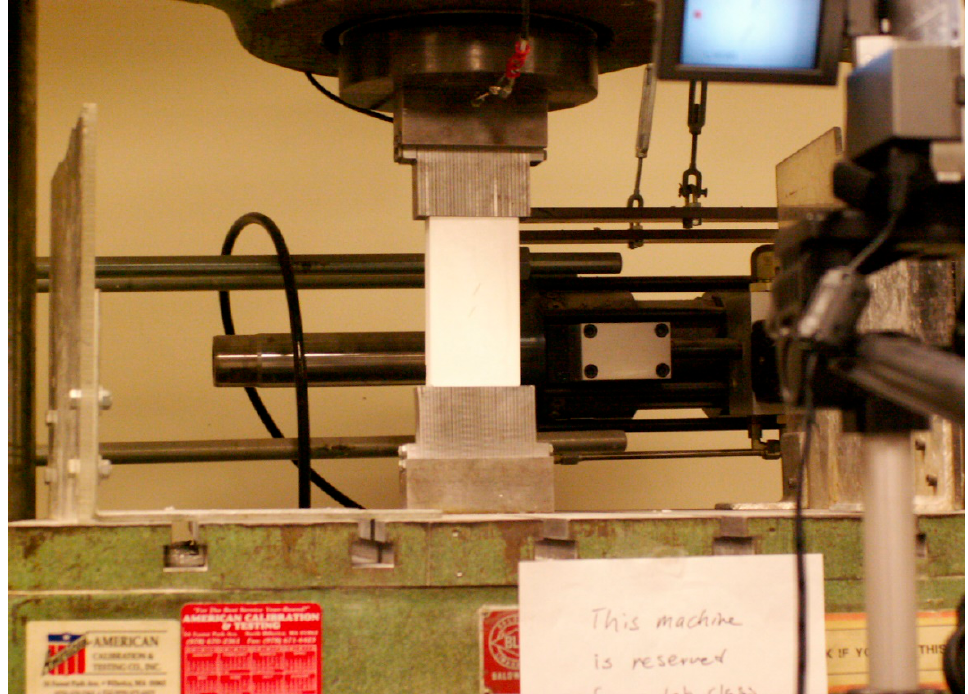
Figure 3. Experimental setup for monotonic and cyclic compression.